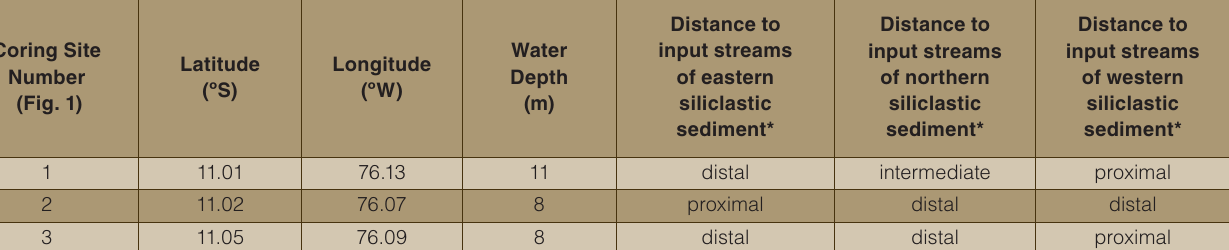
Table 1. Proposed drill sites for Lake Junin.